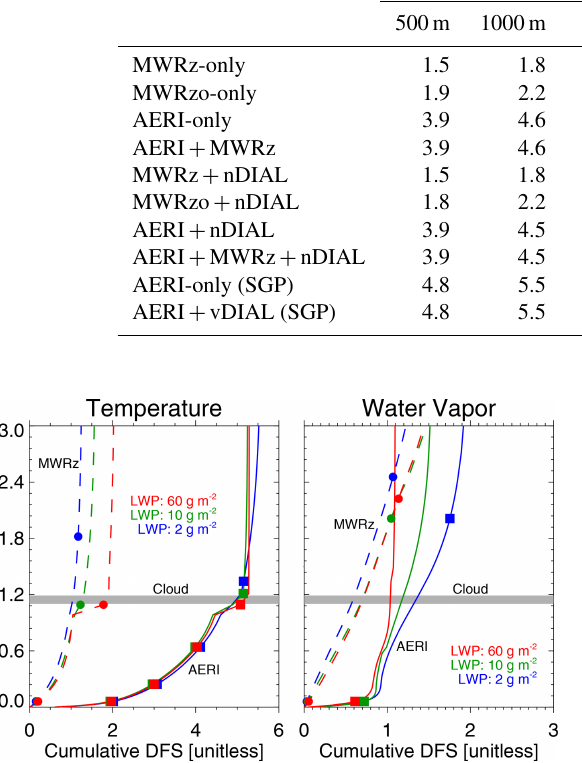
Figure 6. Profiles of cumulative degrees of freedom of signal from MWRz-only (dashed curves with dots) and AERI-only (solid curves with squares) temperature (left) and water vapor (right) retrievals for three samples between 03:00 and 05:00 UTC on 27 May 2017 during Perdigão. The different colors correspond to different LWP path values in the overhead cloud, whose height is indicated with the horizontal gray bar. The solid symbols indicate heights that would be assimilated if the first level started at 50ma.g.l., and each level was separated by a unit of DFSs. See the text for more